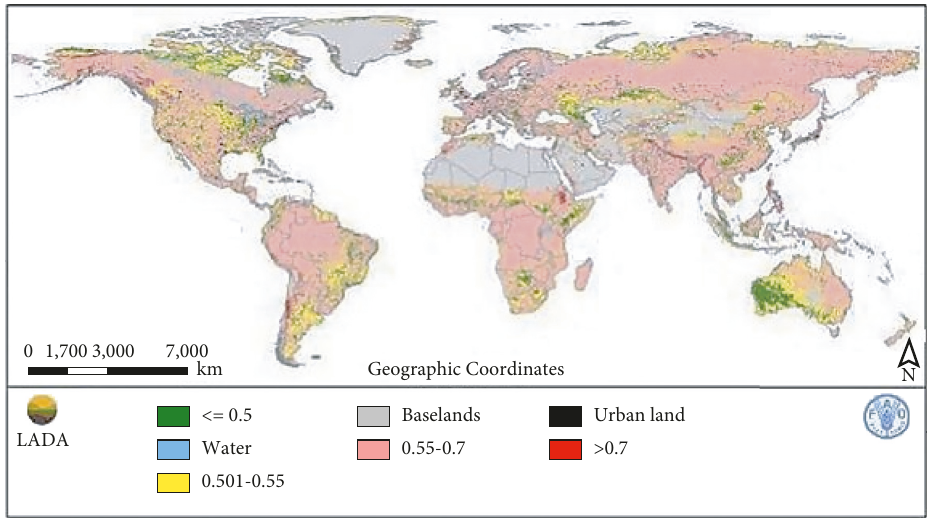
Figure 1: Degraded land across the globe [24].